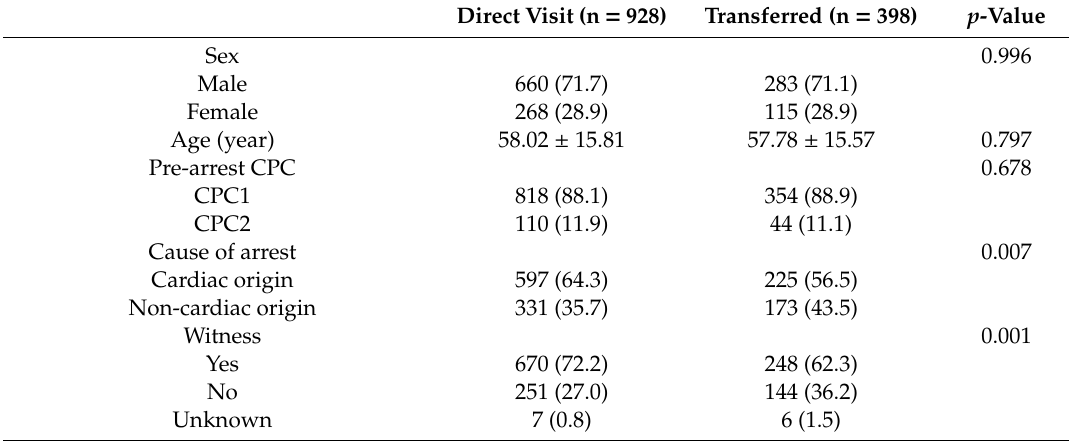
Figure 1. Flow chart describing the enrolment of patients in this study. OHCA: out-of-hospital cardiac arrest; ROSC: return of spontaneous circulation; TTM: targeted temperature management; DNAR: do-not-attempt resuscitation; CPC: cerebral performance category; ECG: electrocardiography. Table 1. Baseline characteristics of the enrolled